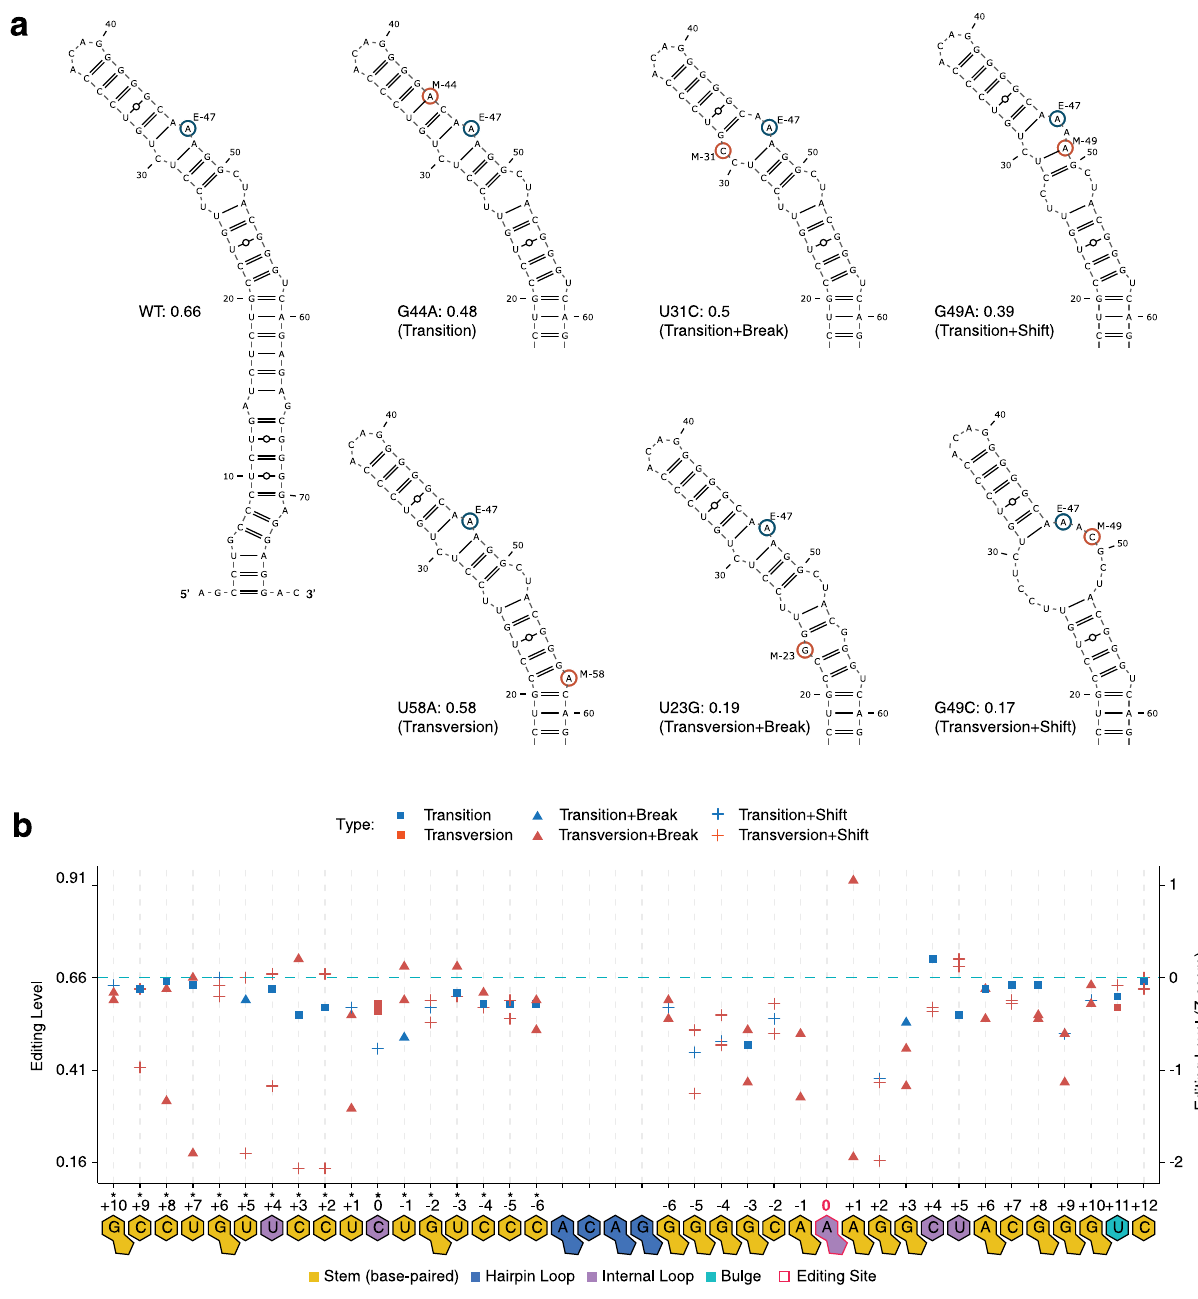
Fig. 3 Effects of NEIL1 single mutations on RNA structure. a Editing site is indicated by blue circle and the mutation site is marked by red circle. The editing level shown is the average value from six biological replicates. The single mutations were grouped into six types: sequence change (transition or transversion) without change in the structure, the sequence change (transition or transversion) resulted in breaking of the base pair at the mutation site (break), or resulted in breaking more than one base pair or forming of new base pair(s) (shift). E editing site, M mutation site. b Position-speci fi c effects of NEIL1 single mutations, categorized by six types: transition mutation that does not affect RNA secondary structure (transition, blue square), transition mutation that disrupt the base pair at the mutation site (transition + break, blue triangle), transition mutation that leads to disruption of more than one base pair and/or formation of new base pair (transition + shift, blue cross), transversion mutation that does not affect RNA secondary structure (transversion, red square), transversion mutation that disrupt the base pair at the mutation site (transversion + break, red triangle), transversion mutation that leads to disruption of more than one base pair and/or formation of new base pair (transversion + shift, red cross). The Z -score is calculated for the NEIL1 RNA library as described in “ Methods ” and the WT editing level Z -score is ( * + 1 to * + 8). Double-transversion mutations in the editing smaller ( Z -score > − 2) if one of the mutations was in a non-base- strand of NEIL1 had overall pronounced effects on editing paired region ( + 4, + 5, + 11; Fig. 2d). (Fig. 2d), and the strongest effects ( Z -score < − 2) were observed when at least one of the mutations was in close proximity to the TTYH2 . In contrast to NEIL1, where the vast majority of muta- editing site (positions – 6 and + 2). The effect was generally tions decreased editing, a large proportion of TTYH2 single